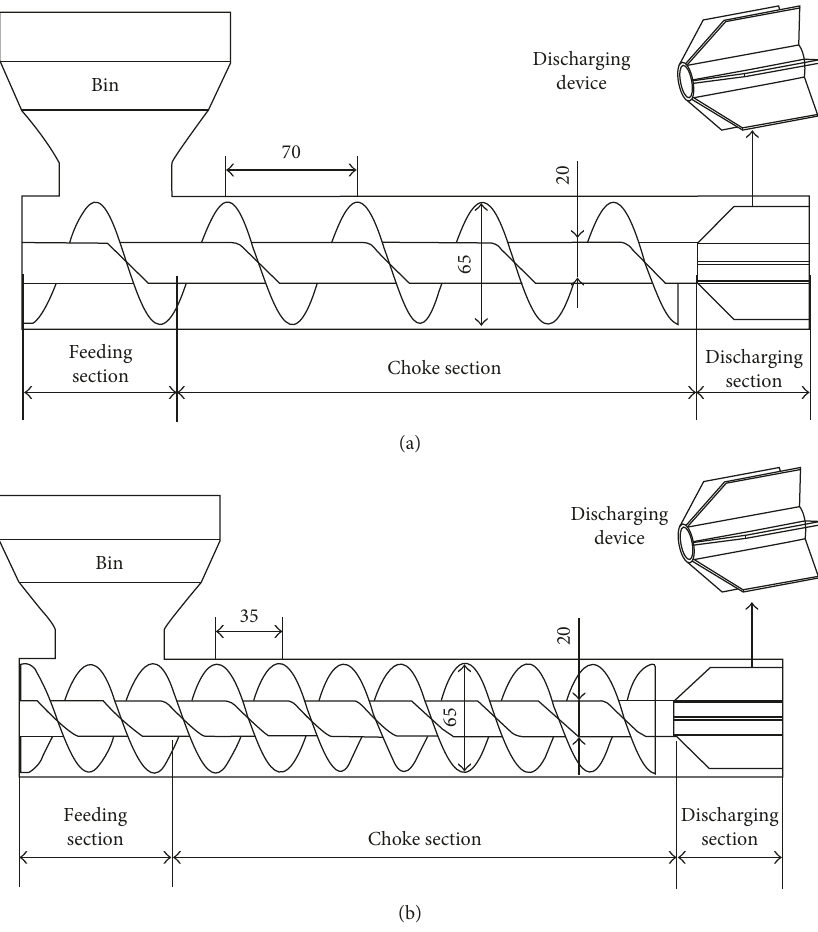
Figure 2: The geometry model of the screw feeder.